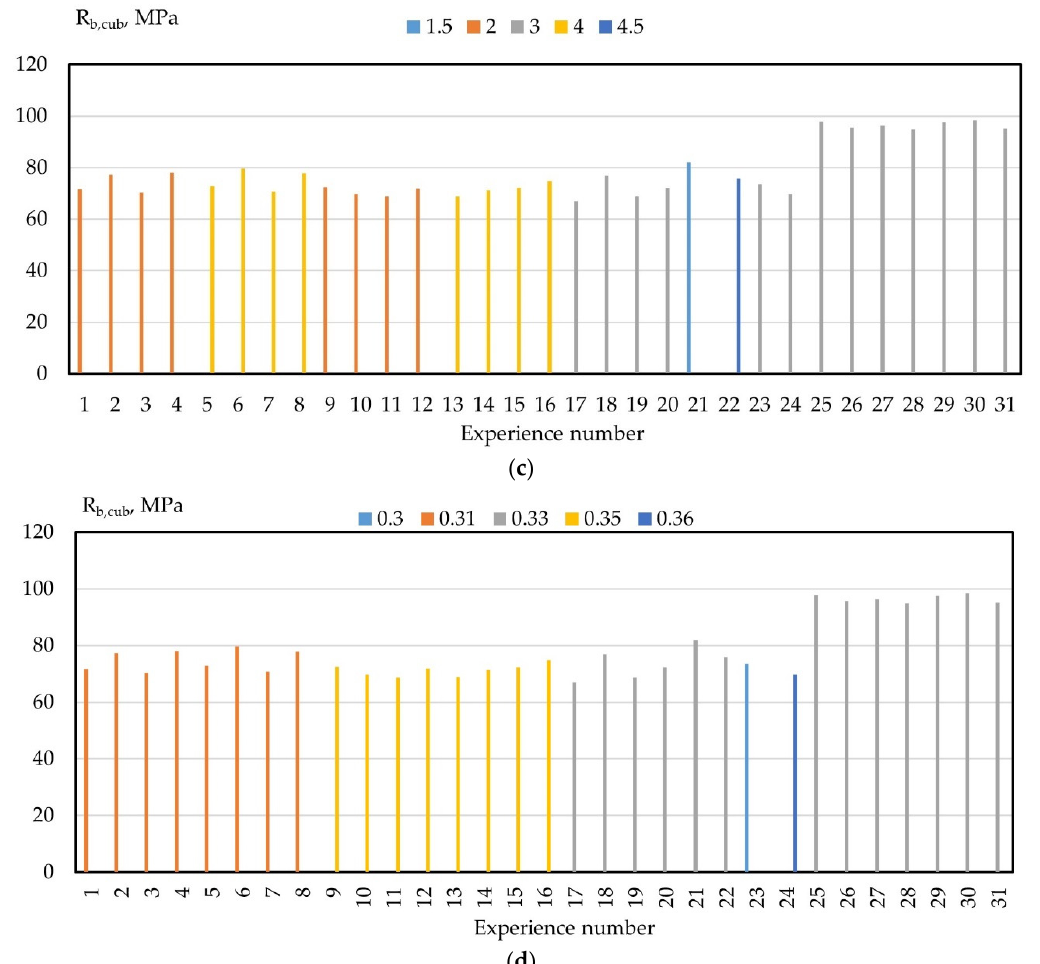
Figure 4. Dependence of the compressive strength of high-strength concretes on factors: ( a ) X 1 ; ( b ) X 2 ; ( c ) X 3 ; and ( d ) X 4 .